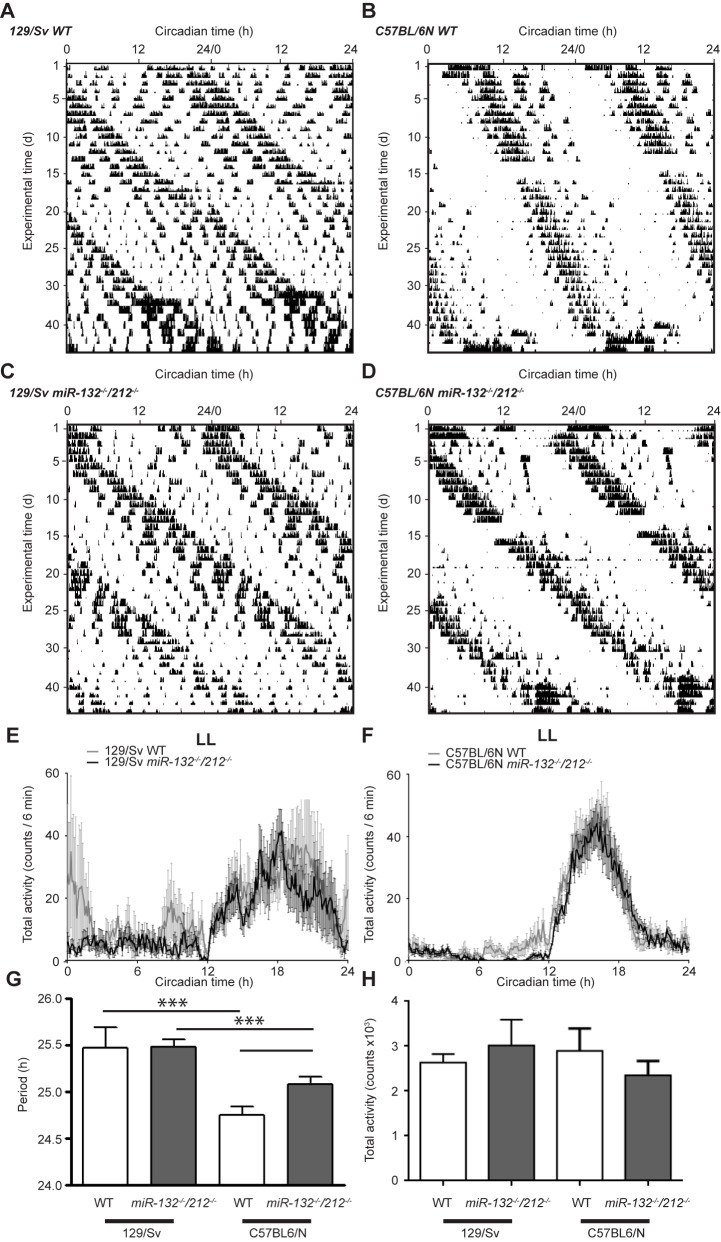
Influence of miR-132/212 deletion on the period length in constant light.(A-D) Representative double-plotted actograms of WT (A, B) and miR-132-/-/212-/- (C, D) mice in constant light conditions. (E, F) Total activity profiles of WT and KO mice in 129/Sv (E) and C57BL/6N backgrounds (F). (G, H) Period length (G) and total activity (H) in constant light of 100 lx for all genotypes. Period length: 129/Sv: WT: 25.47 ± 0.22 h, n = 6; KO: 25.49 ± 0.08 h, n = 7; C57BL/6N: WT: 24.71 ± 0.08 h, n = 10; KO: 25.08 ± 0.08 h, p = 0.0143, n = 11, two-way ANOVA for interaction: F(1, 29) = 4.341, p = 0.0461, Sidak’s post-hoc test for background differences: p < 0.001, Sidak’s post-hoc test for genotype differences 129/Sv: p > 0.05, C57BL/6N: p < 0.05. Total activity: 129/Sv: WT: 2,636 ± 190 counts, n = 5; KO: 3,016 ± 576 counts, n = 6; C57BL/6N: WT: 2,895 ± 499 counts, n = 10; KO: 2,352 ± 319, n = 10,; two-way ANOVA for interaction F(1, 27) = 0.9622, p = 0.3353, two-way ANOVA for background F(1, 27) = 0.185, p = 0.6705, two-way ANOVA for genotype F(1, 27) = 0.02991, p = 0.8640. Data are represented as mean ± SEM., * p < 0.05.